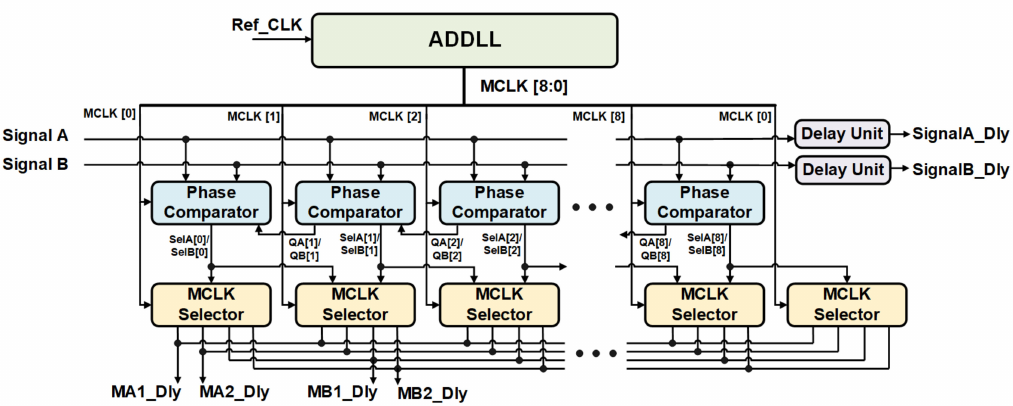
Figure 6. Circuit diagram of the ADDLL stage.